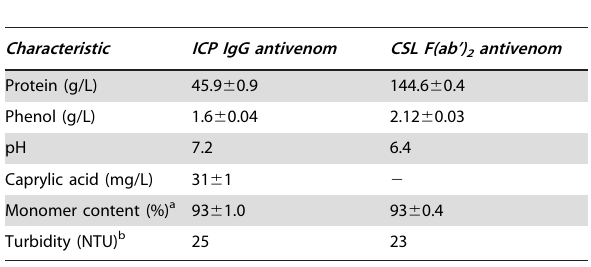
Table 1. Physicochemical characteristics of